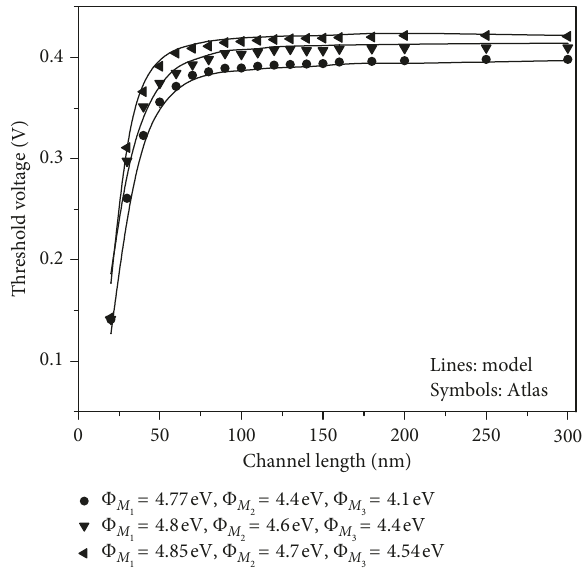
Figure 7: DIBL for the different values of recessed-source/drain